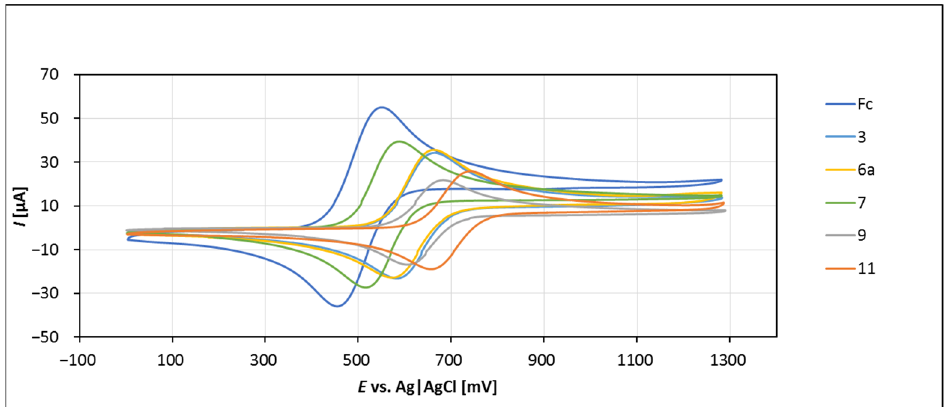
Figure 2. Cyclic voltammograms of ferrocene-benzofuran hybrids and ferrocene (Fc) (working electrode: glassy carbon, reference electrode: Ag/AgCl (H 2 O), auxiliary electrode: Pt wire, concentration: 2.5 × 10 − 3 M in CH 2 Cl 2 , supporting electrolyte: 0.1 M n -Bu 4 NPF 6 , scan rate: 50 Table 2. Diffusion coefficients ( D ), half wave potentials ( E 1/2 ) and redox potentials relative to fer- rocene ( E rel ) of ferrocene–benzofuran hybrids a .